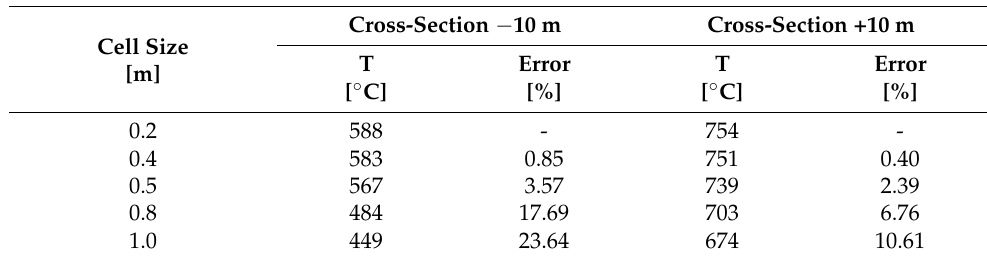
Table 2. Grid sensitivity analysis: temperature values at driving lane center 5.5 m from the road